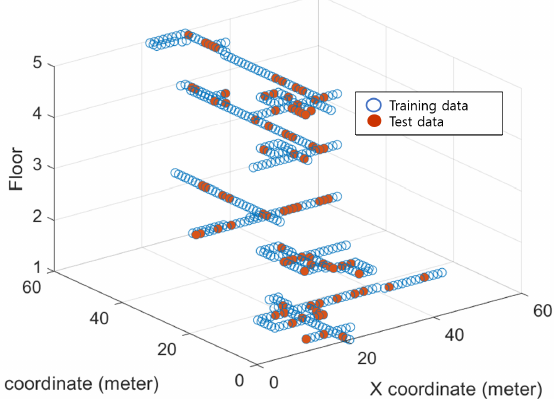
Figure 4. Experimental WiFi fingerprint data distribution along hallway of a multi-story